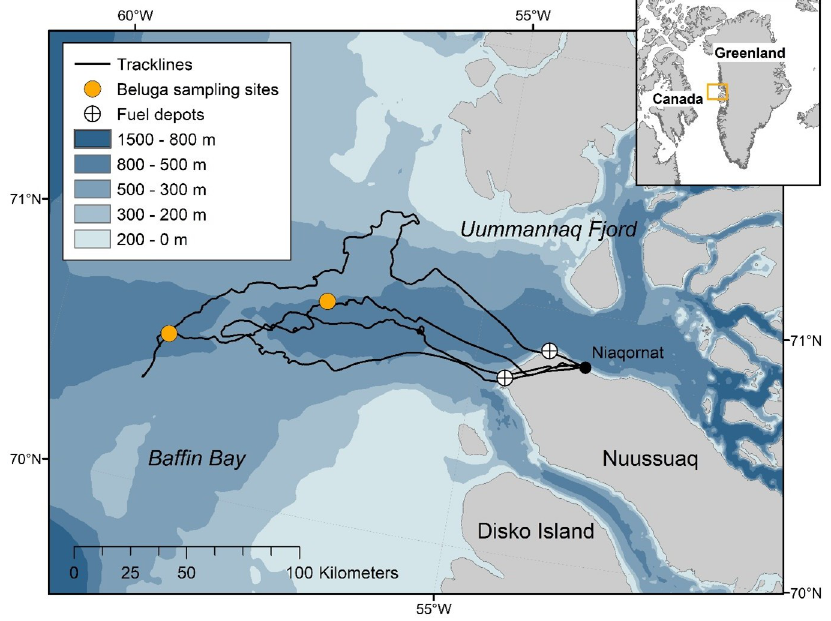
Fig 1. Map of study region in Baffin Bay, West Greenland. Includes track lines of search effort, fuel depots, and sampling locations on March 25 and 31 st , 2013.